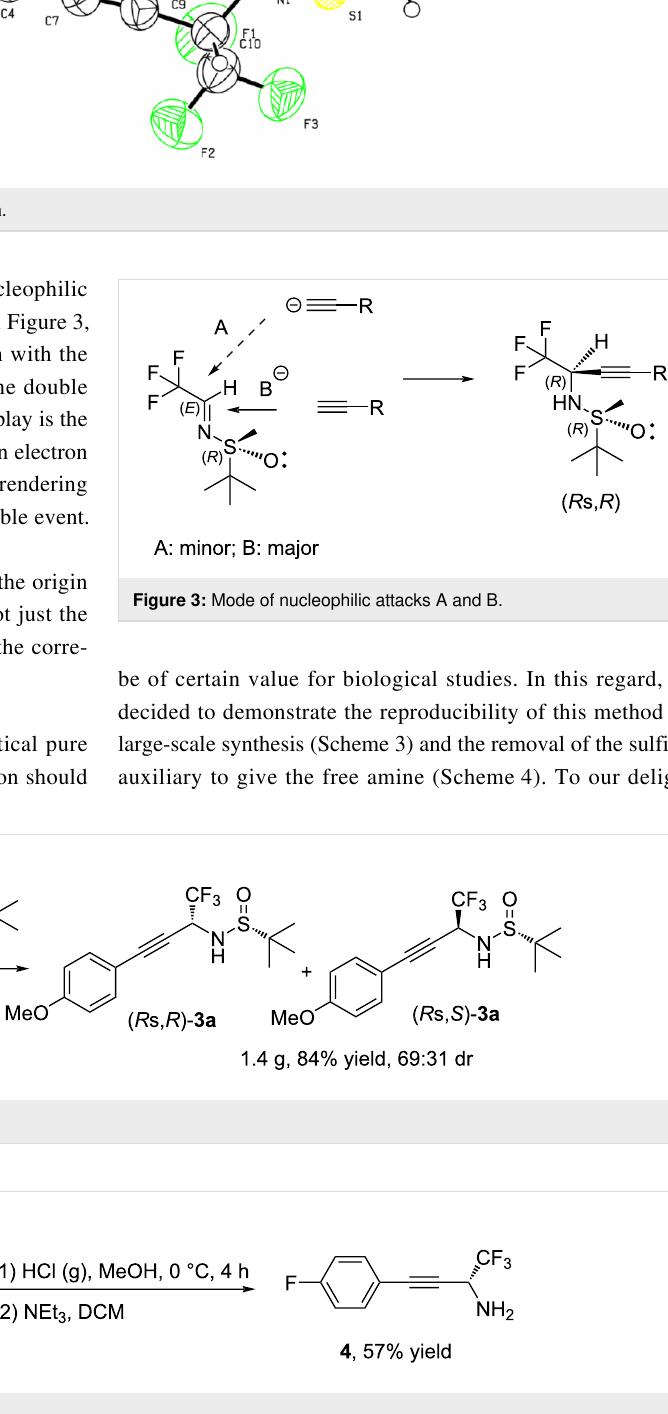
Scheme 4: Removal of the chiral auxiliary.